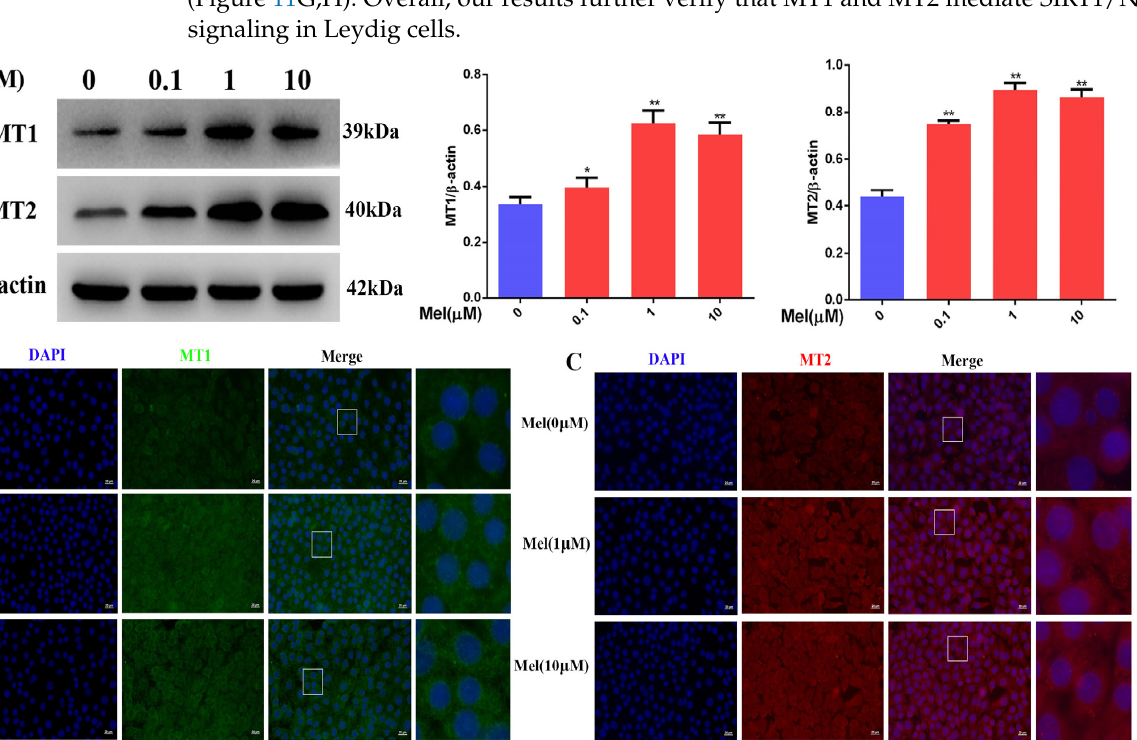
Figure 10. Melatonin could attenuate the downregulation of the MT1, MT2, and SIRT1/Nrf2 signal- ing pathways by cisplatin in Leydig cells. ( A ) Determination of MT1 and MT2 protein levels was performed by Western blotting in Leydig cells treated with different concentrations of melatonin for 24 h. The blots were quantified using Image J software. ( B ) MT1 immunofluorescence in Leydig cells treated with 1 μ M of melatonin. MT1 was tagged with green fluorescence. The nucleus was labeled with DAPI (scale bar = 20 μ m). ( C ) MT2 immunofluorescence in Leydig cells treated with 1 μ M of melatonin. MT1 was tagged with red fluorescence. The nucleus was labeled with DAPI (scale bar = 20 μ m). ( D ) Determination of Nrf2, HO-1, and NQO1 protein levels was performed by Western blotting in cisplatin-induced Leydig cells pretreated with different concentrations of melatonin or ramelteon. The blots were quantified using Image J software. ( E ) Determination of the SIRT1, SOD1,